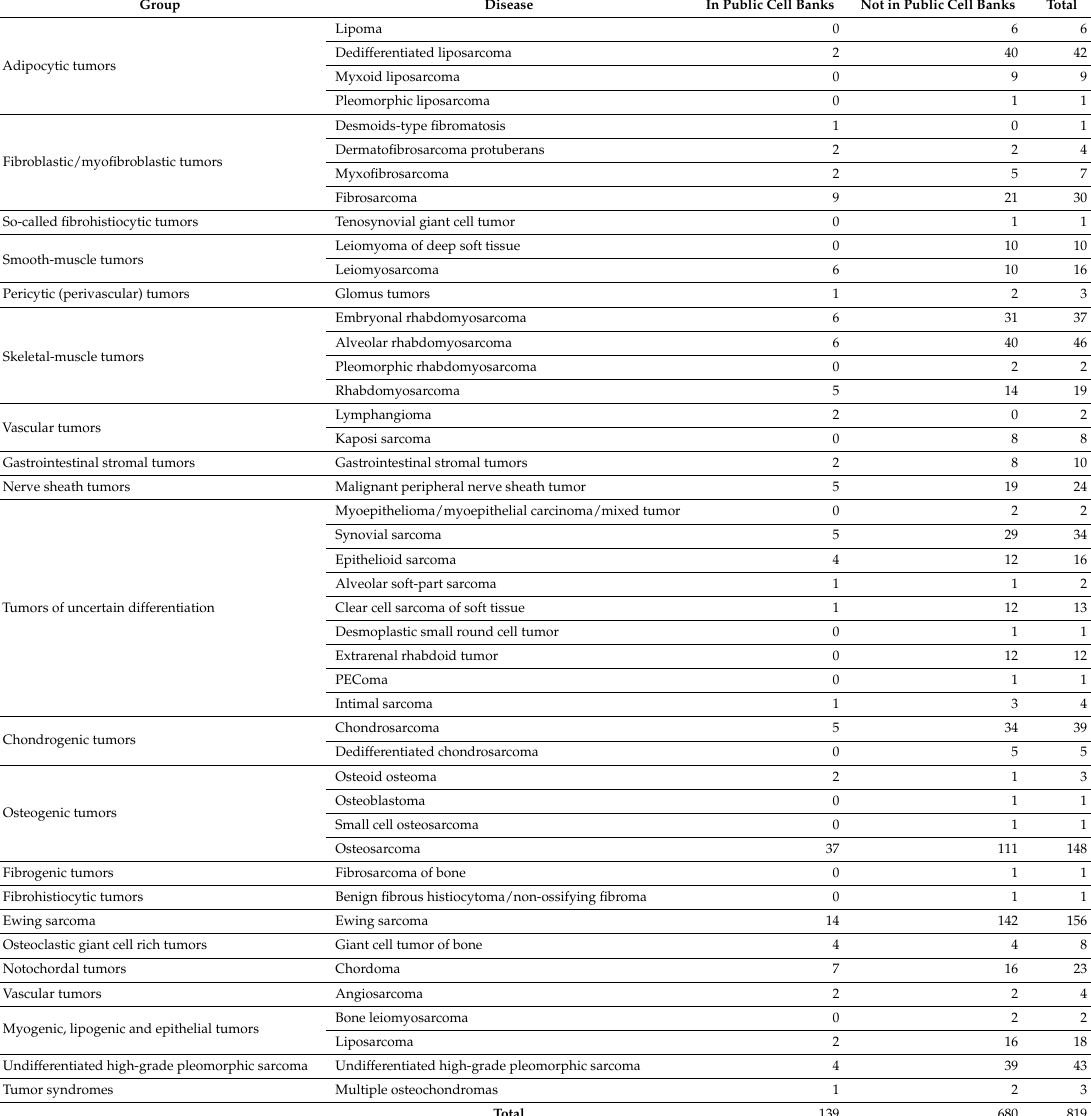
Table 1. Availability of WHO classified original cell